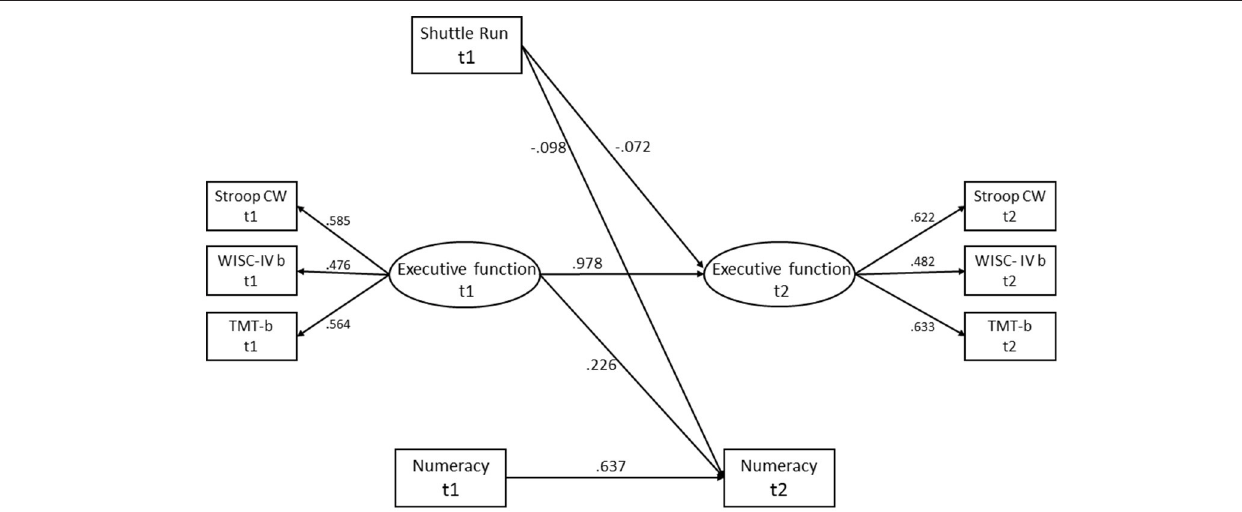
FIGURE 2 | The half-longitudinal mediation model for executive function in the relation between Shuttle Run and numeracy. All path coefficients are significant and reported as standardized β -estimates. The covariates age, sex, tanner, body fat, socio economic status, and group allocation are adjusted for in the model, but not shown. t1, baseline; t2, follow-up; Stroop CW, Stroop Color Word; WISC-IV backward, Wechsler Intelligence Scale for children fourth edition backward; TMT-b, the Trail Making test part